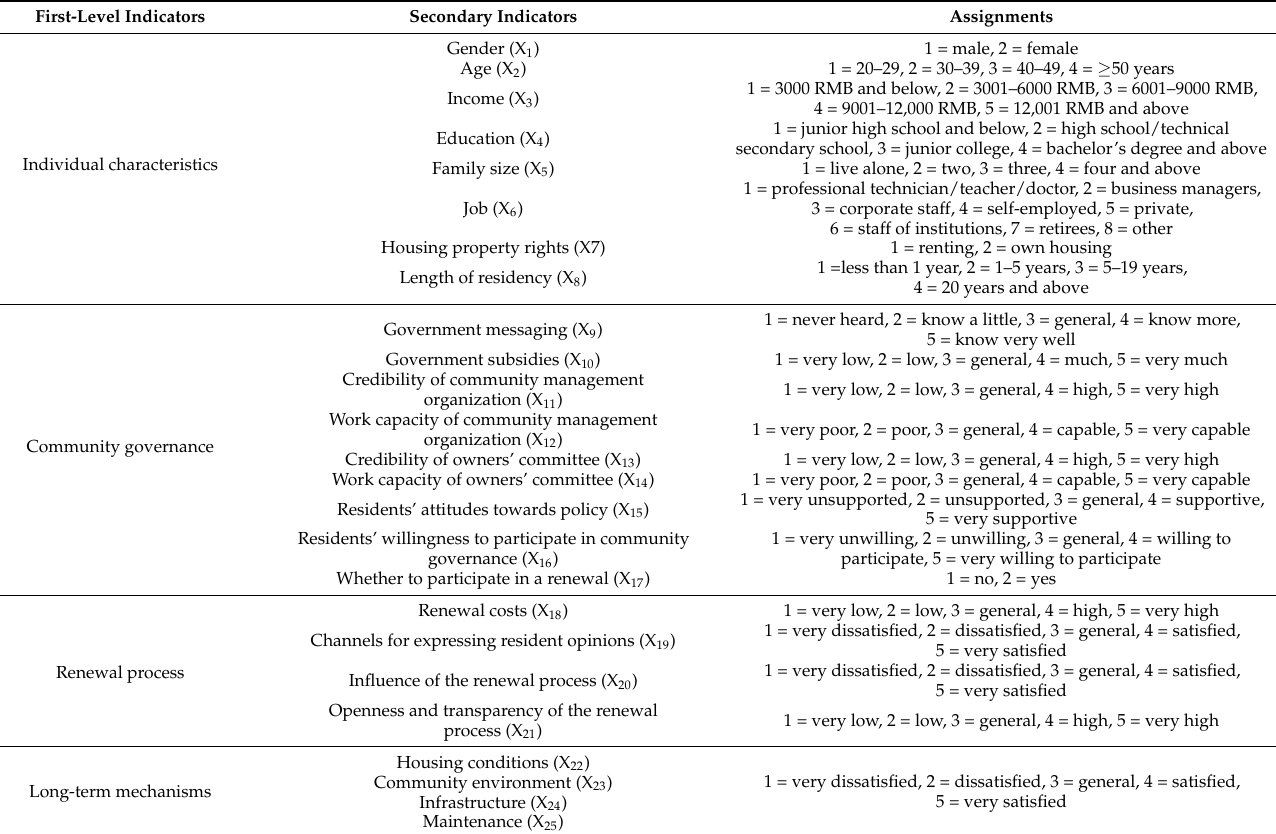
Table 1. Variables and